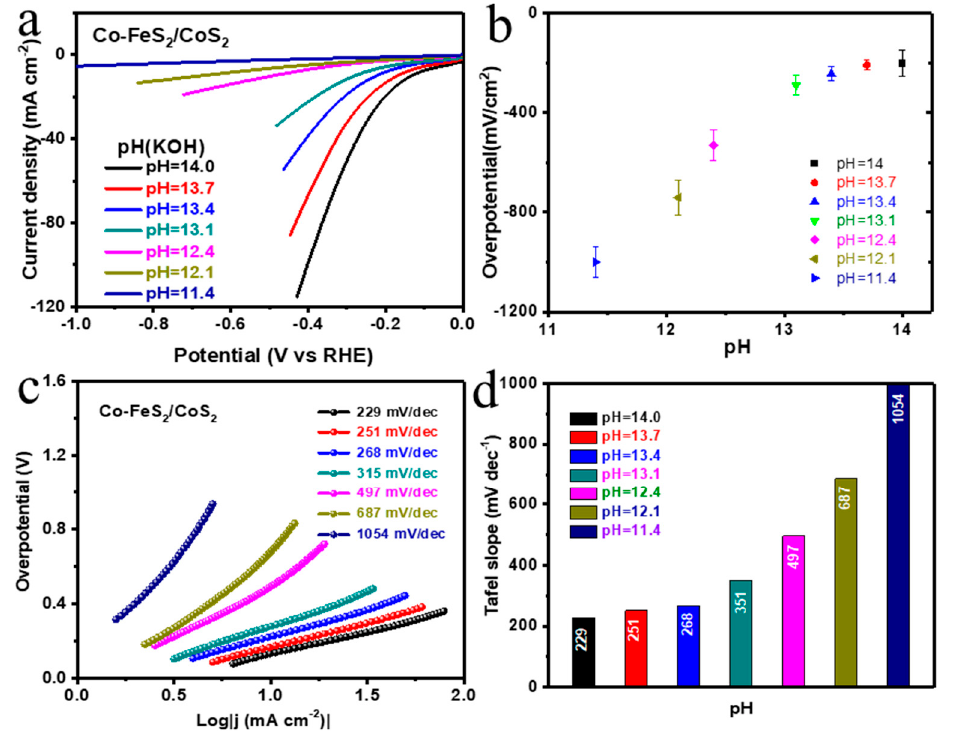
Figure 3. ( a ) LSV polarization curve of Co-FeS 2 /CoS 2 heterostructure in KOH solutions of different pH; ( b ) Scatter plot corresponding to overpotential at current density 10 mV cm − 2 in Figure 3a; ( c ) Tafel diagram of Co-FeS 2 /CoS 2 heterostructure in KOH solutions of different pH; ( d ) Histogram corresponding to the slope of Tafel in Figure 3c.